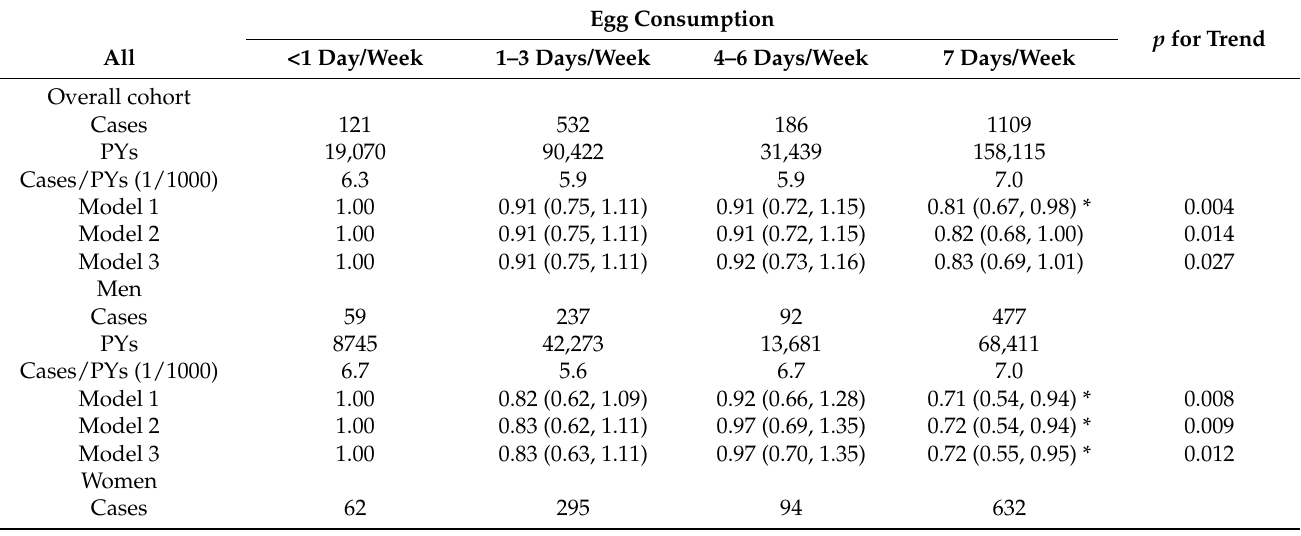
Table 2. Hazard ratios (HRs) and 95% confidence intervals (CIs) for Cerebrovascular Events Accord- ing to Egg